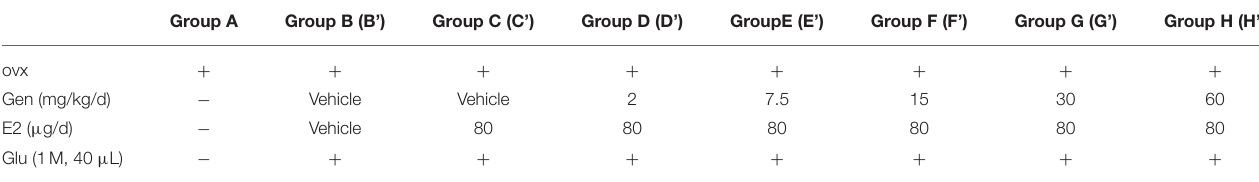
TABLE 1 | Experimental groups of genistein treatment. Group A Group B